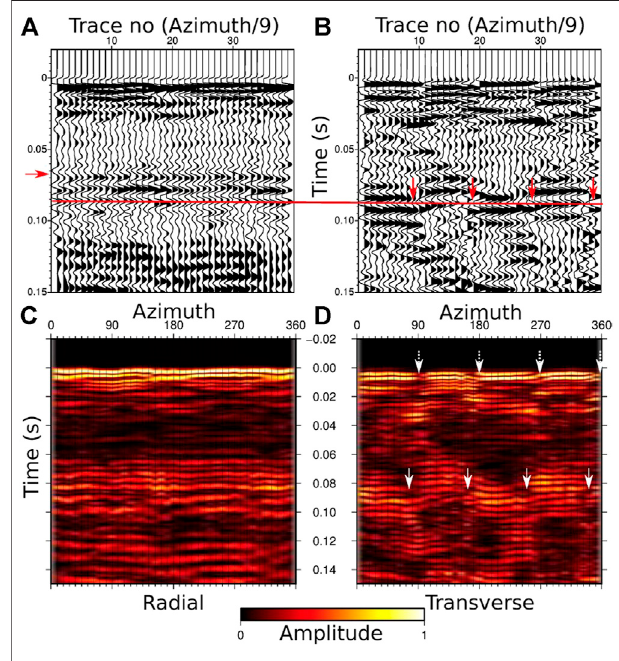
FIGURE 6 | 9 ° azimuth stacks recorded on OBS1 located within the pockmark. Left and right panels show radial and transverse components respectively. (A) Radial wiggle plot. The red arrow shows the arrival time ( ∼ 65 ms TWT) of the C-wave phase on the radial seismogram. Red line shows the time at which the event is observed with highest amplitude due to ringing (see text). (B) Transverse wiggle plot. Red arrows show the polarity changes at 90 ° interval. (C) Radial envelope plot of the amplitudes (root of squared amplitudes). (D) Transverse envelope plot. White arrows show the amplitude nulls at ∼ 90 ° intervals, corresponding to the orientation of the anisotropy axes (70 and 150 ° ). Dashed white arrows at t (cid:2) 0 indicate the geophone